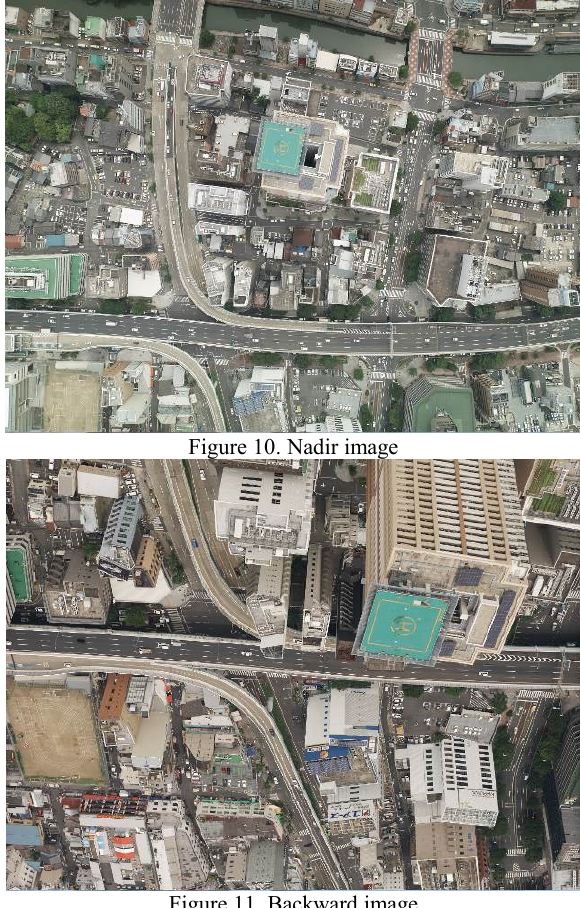
Figure 11. Backward image